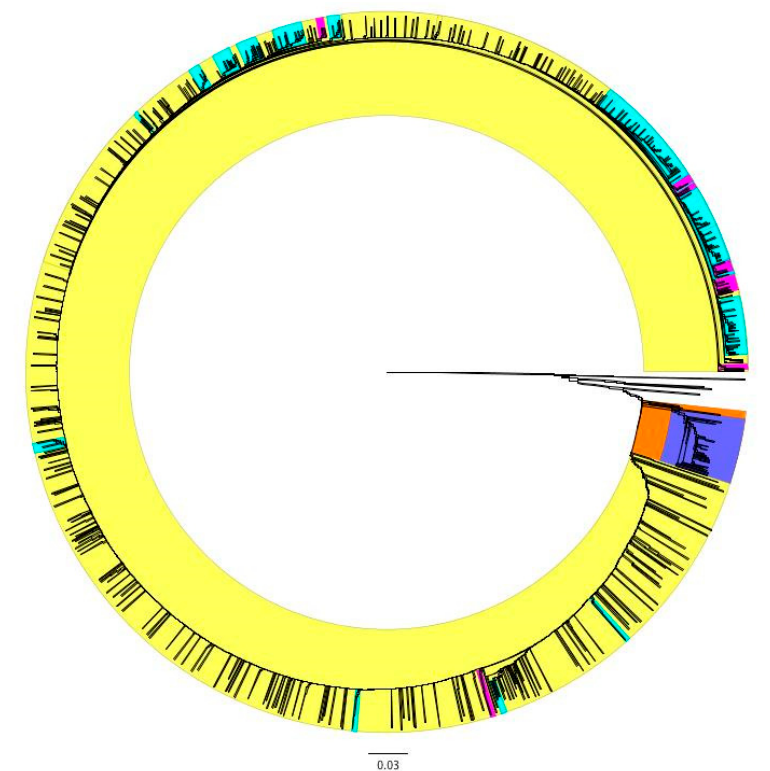
Figure 3. Dendrogram of pESI plasmids ( n = 2627) based on the presence and absence of genes detected in two or more isolates. Clusters are colored based on the geographic source of the plasmid or the bacterial host. Orange cluster only contained plasmids from Peru and one from Ecuador. Purple cluster is a sub-cluster of the orange cluster containing isolates with a specific group of genes. Yellow cluster contained plasmids from isolates of various sources. Blue clusters contained a majority of plasmids isolated in bacteria collected from U.S. food. Pink cluster contained plasmids from isolates collected from U.S. or international human cases. Scale represents Jaccard distance.